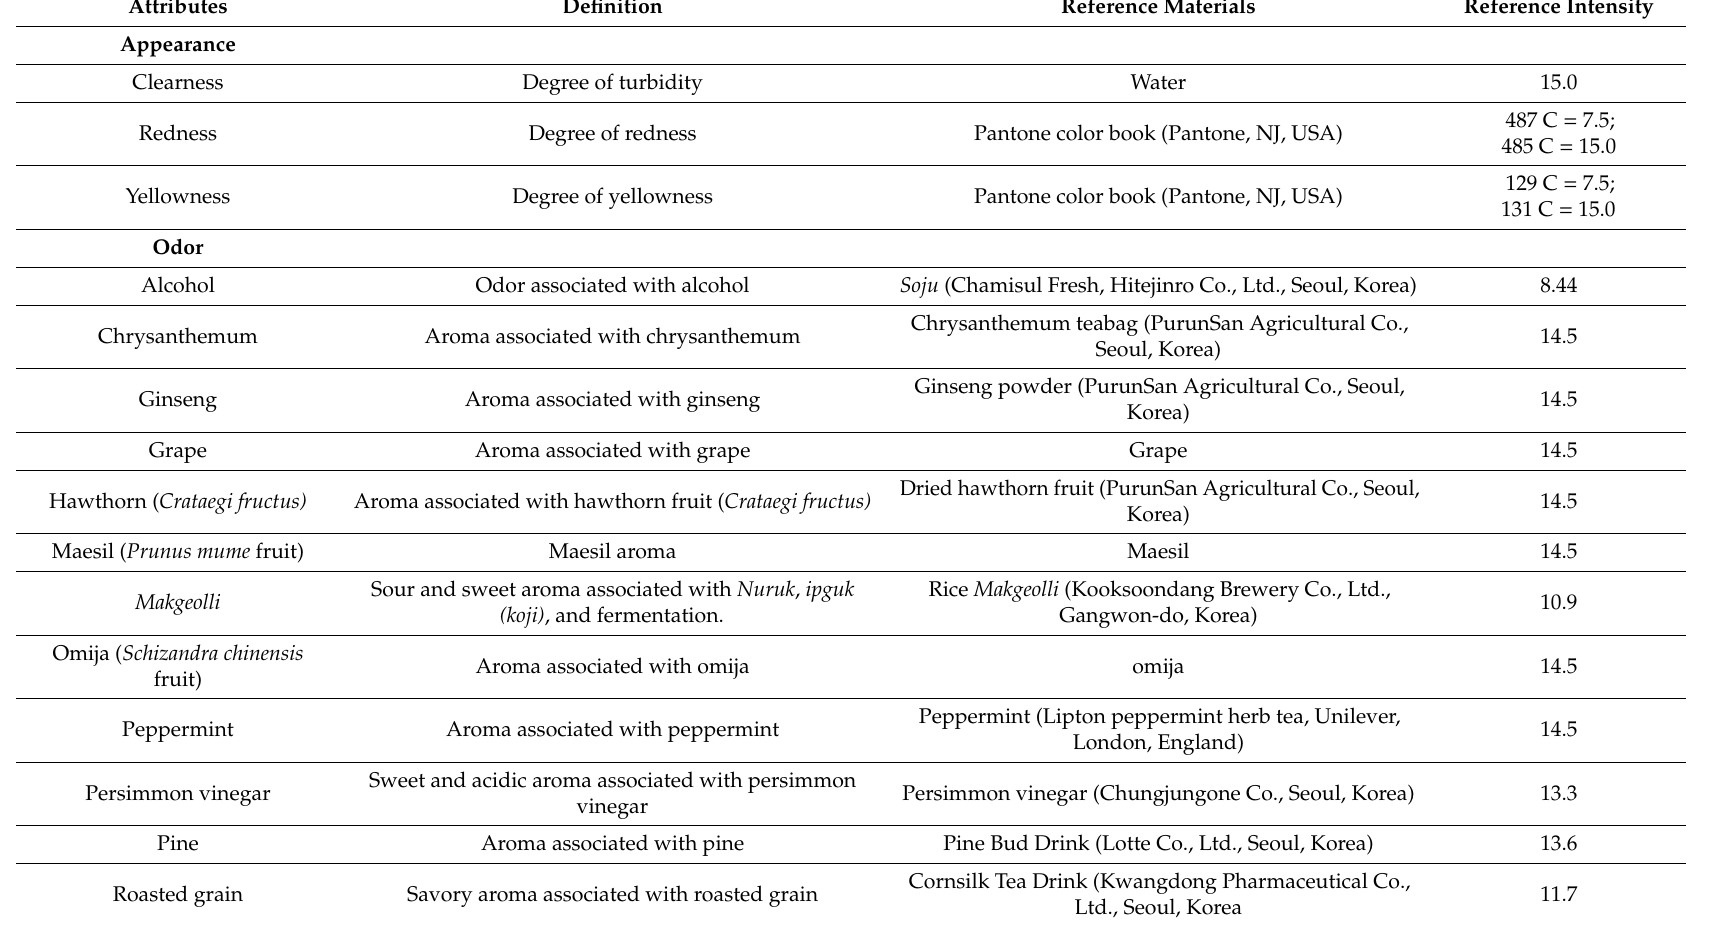
Table 2. Descriptors, definitions, and reference materials of 12 yakju